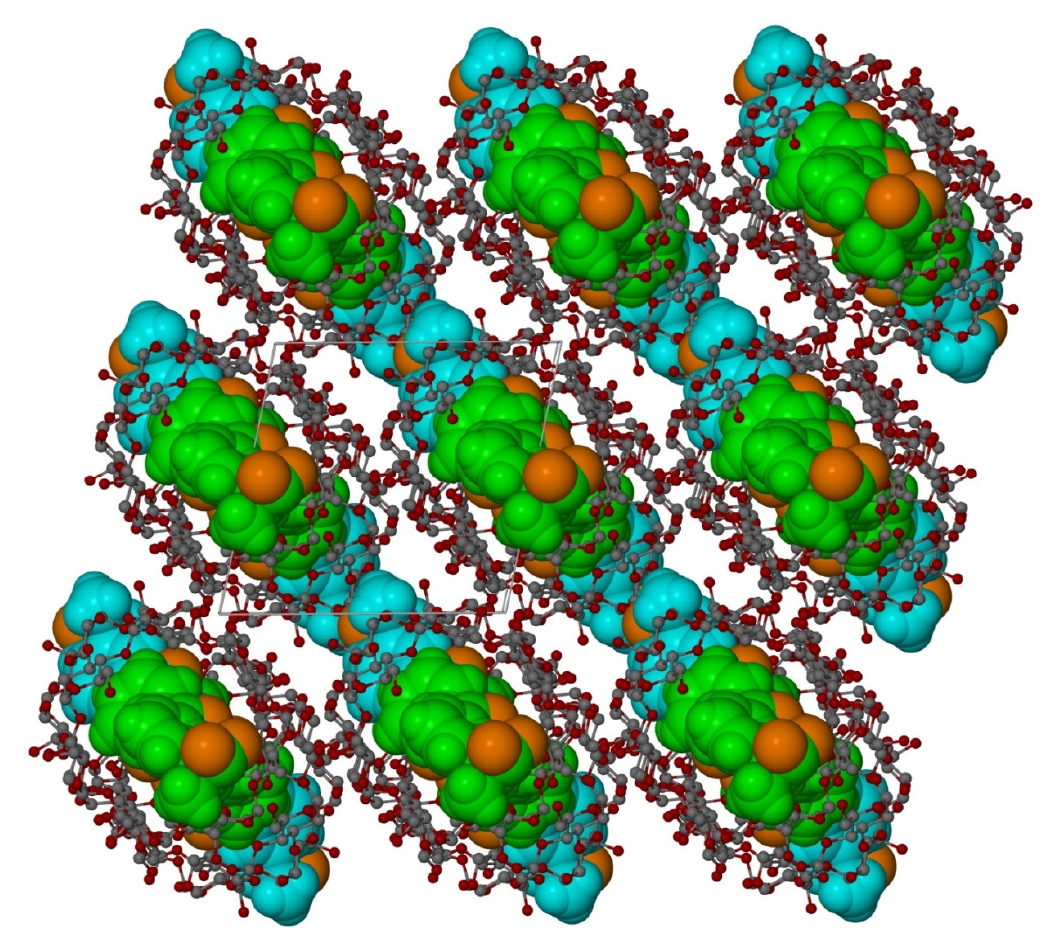
Figure 7. Autostereogram of the crystal structure in b-direction. Only one KP conformation for every blue and green molecule is shown.